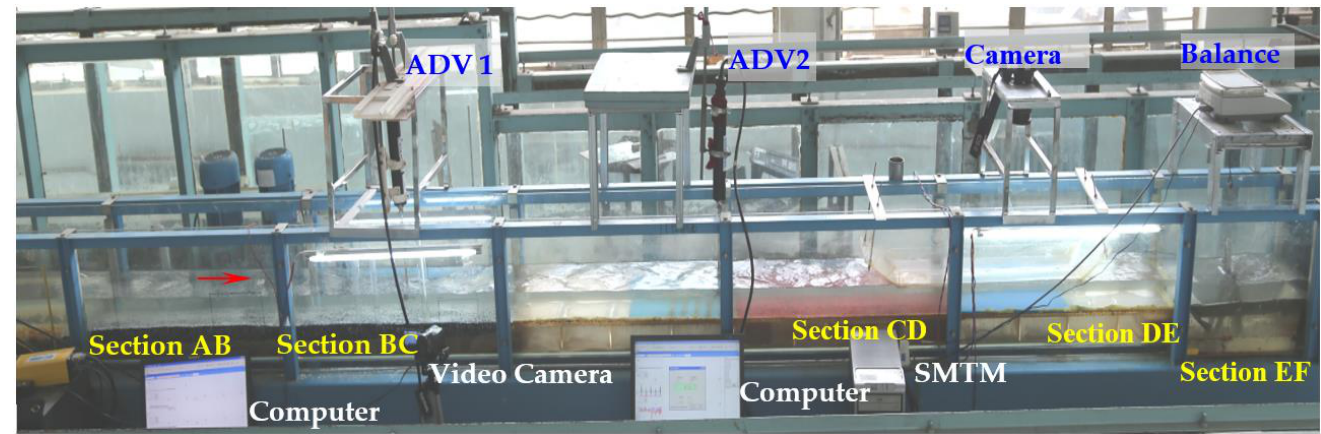
Figure 2. Experimental setup. The figure shows the measurement instruments set in the flume and the locations of test sections, including the water supply, erodible bed, and observation